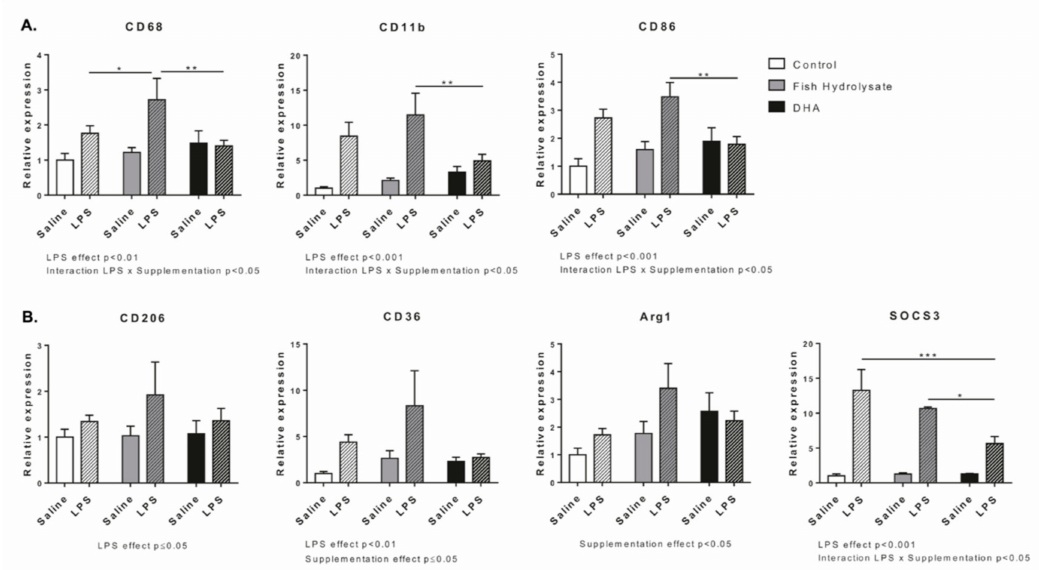
Figure 4. Expression of M1 ( A ) (CD68, CD11b and CD86) and M2 ( B ) (CD206, CD36, Arg1 and SOCS3) microglial markers in the hippocampus of mice fed orally with control solution (in white), fish hydrolysate (in grey) or DHA (in black) by daily gavage for 18 days, 2 h following LPS injection (125 µ g/kg) (hatched bars) (* p < 0.05, ** p < 0.01, *** p < 0.001 by 2-way ANOVA and Fisher’s LSD post hoc test; n = 4–6 per group). Data are presented as mean ± SEM. DHA: docosahexaenoic acid; LPS: